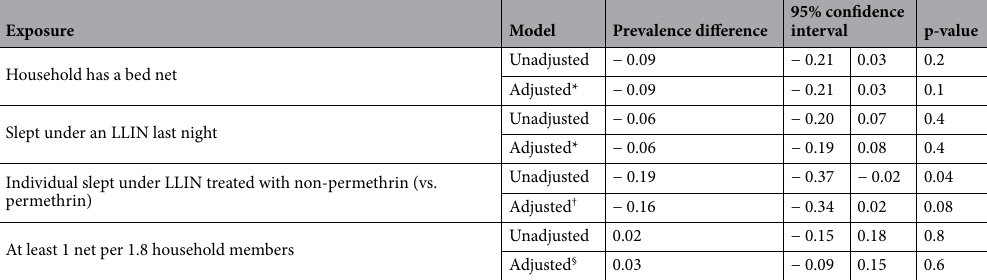
Table 4. Multivariate associations between bed net associated risk factors and P. falciparum prevalence using weighted survey data among pregnant women in the 2015–2016 MDHS who contributed samples to the analysis (n = 319). LLIN long-lasting insecticide treated net. *Models adjusted for age, wealth, and household size. † Model adjusted for age and wealth. § Model adjusted for wealth and